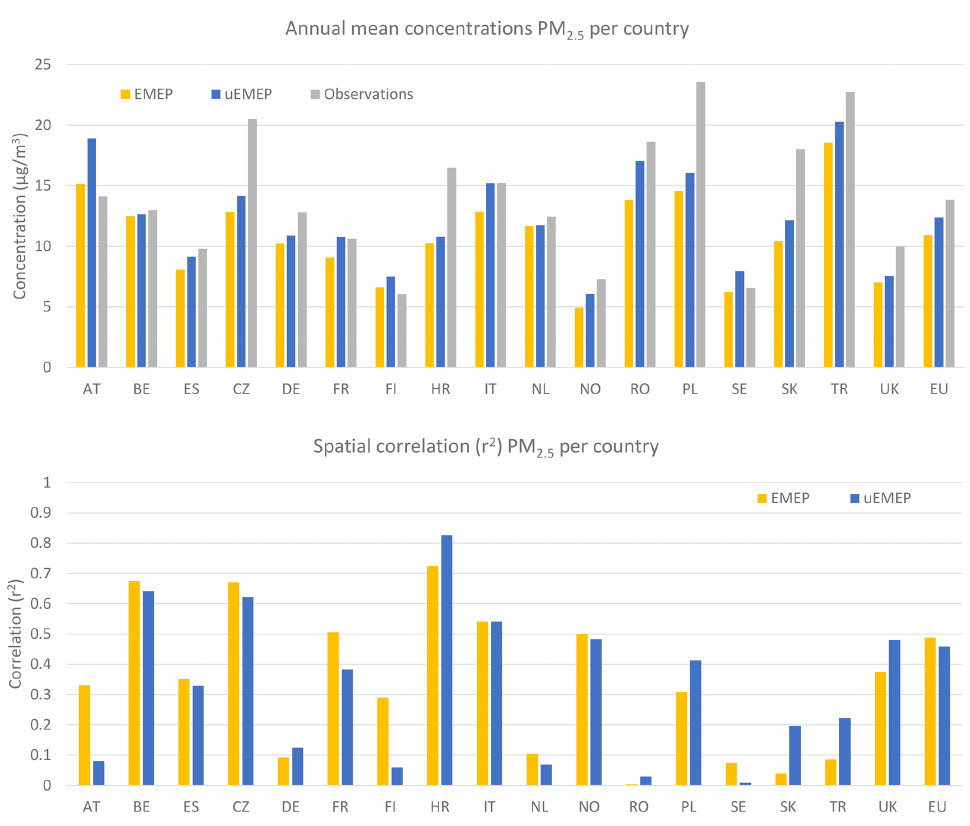
Figure 8. Annual mean PM 2 . 5 concentrations and spatial correlation (coefficient of determination r 2 ) per country for 2018 calculated with the EMEP model and uEMEP compared to AIRBASE observations including all types of stations. Only countries with 10 or more stations are shown, but all stations are included in the final EU result. A total of 1376 stations are included in the